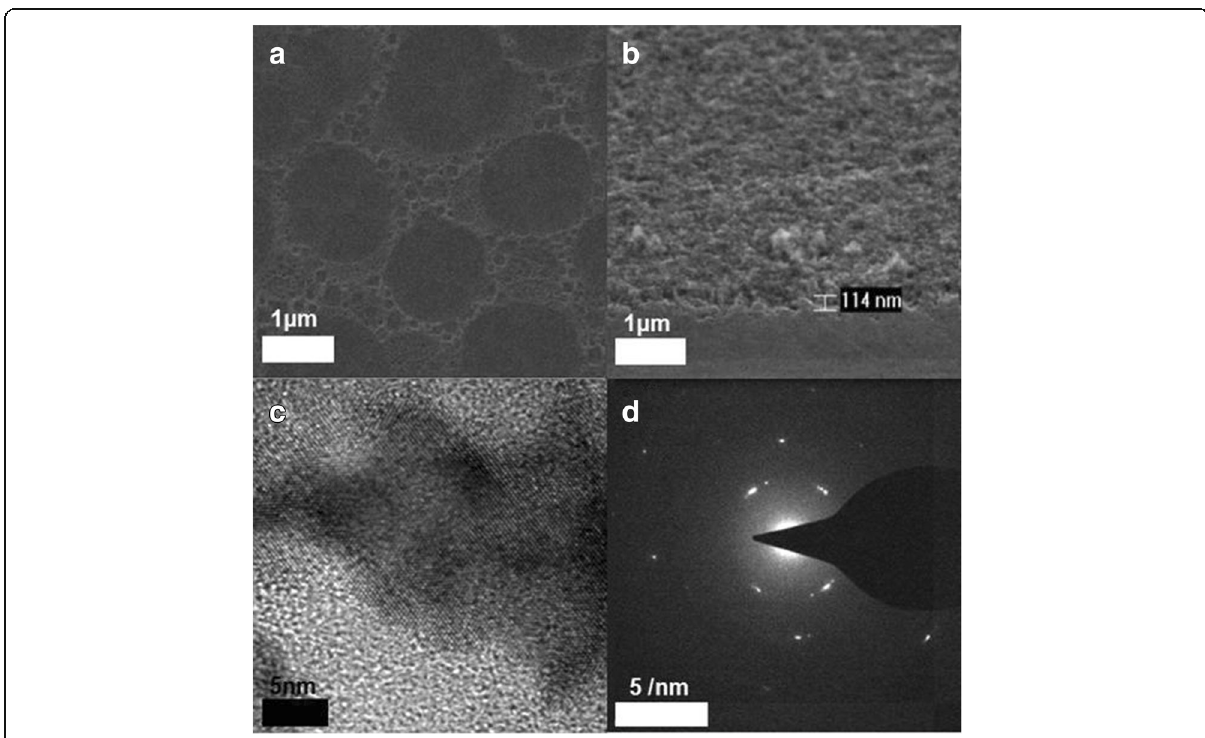
Fig. 2 SEM images of surface-textured Si ( a ) and surface-etched b-Si ( b ), HRTEM ( c ), and SAED ( d ) of